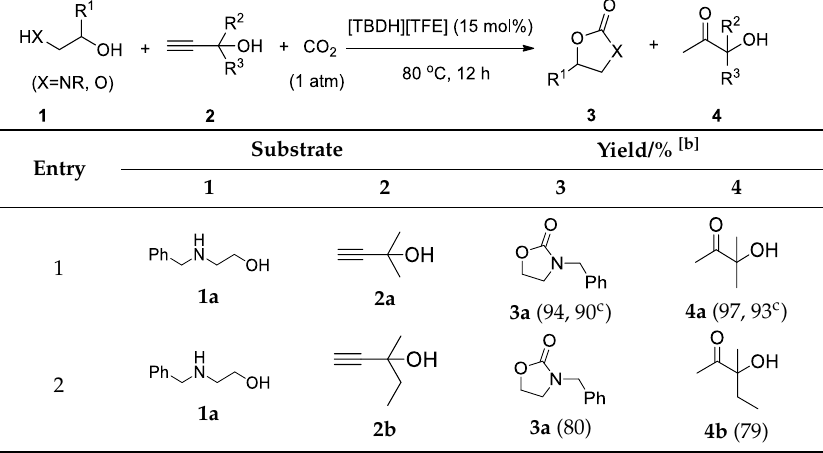
Table 2. Optimization of the reaction conditions. [a].